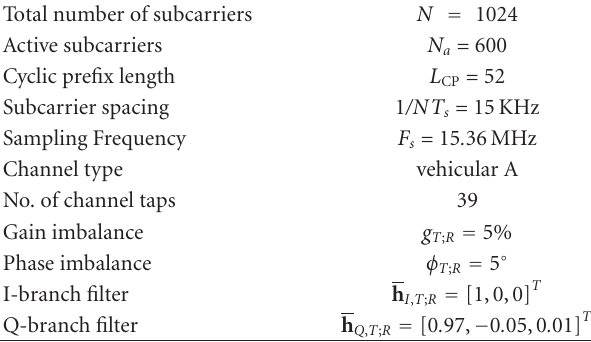
Table 2: System parameters.